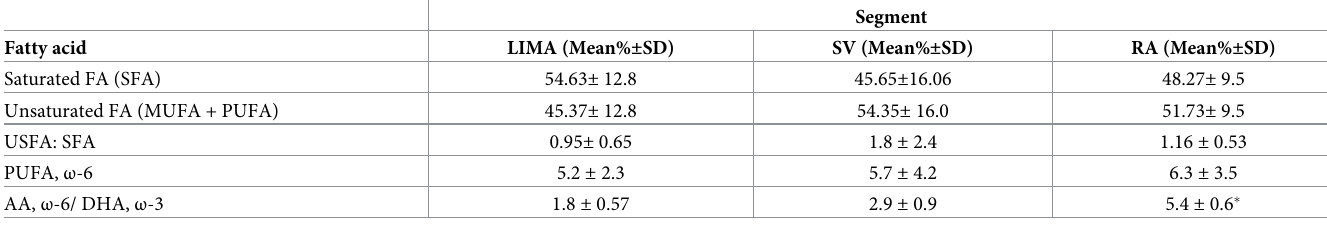
Table 3. Summary of main categories of fatty acids in LIMA, SV and